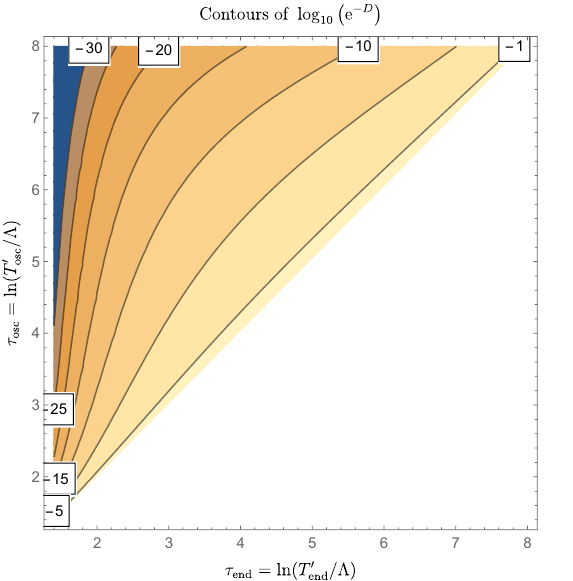
Figure 2 . Contour plot of the overall suppression factor e − D where D given by eq. (3.16) for f = 10 8 GeV and Λ = 150 MeV